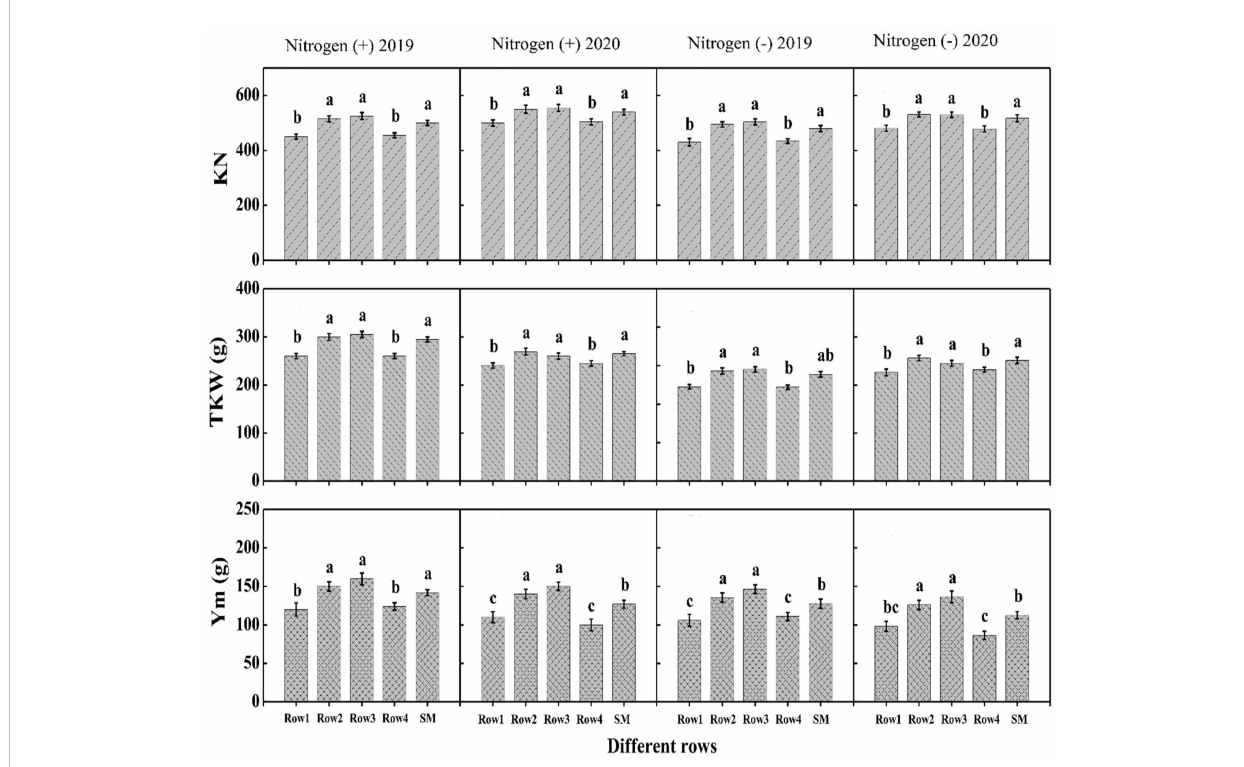
FIGURE 3 The kernel number per ear (KN), thousand kernel weight (TKW) and per meter grain yield (Ym, g) of different maize rows under with- and without N application. Different letters on the top of each bar indicate signi fi cant differences among the crop rows, as calculated by Tukey ’ s HSD test at P ≤